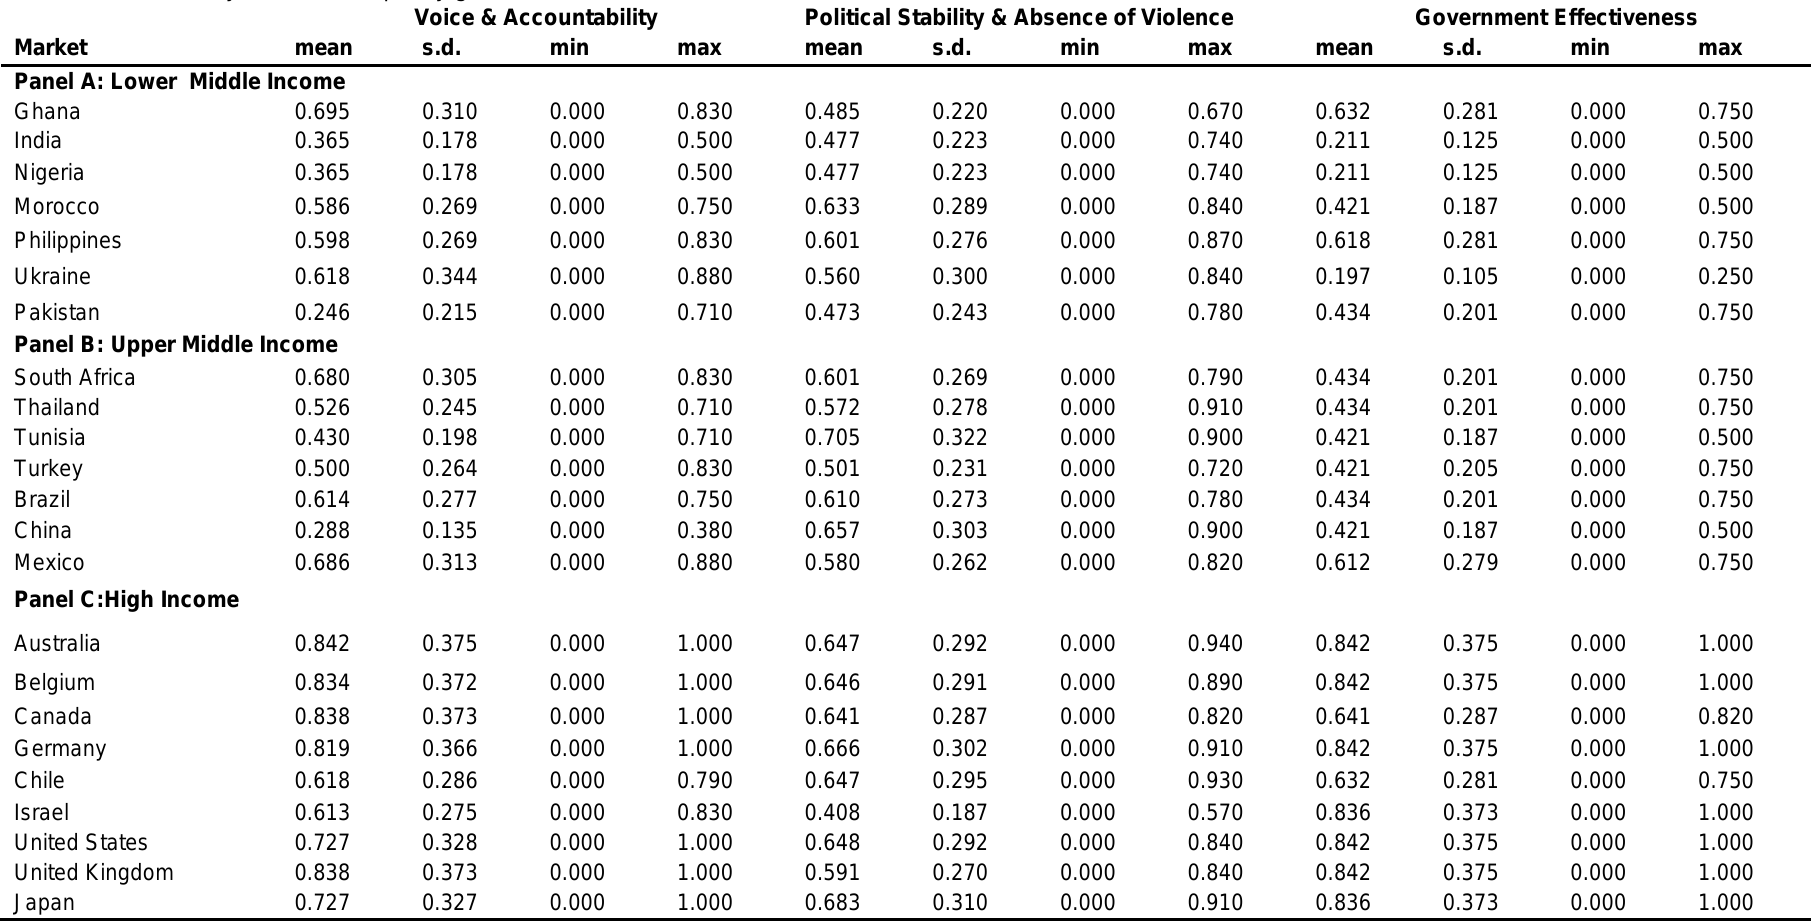
Table 6. Summary statistics of quality governance